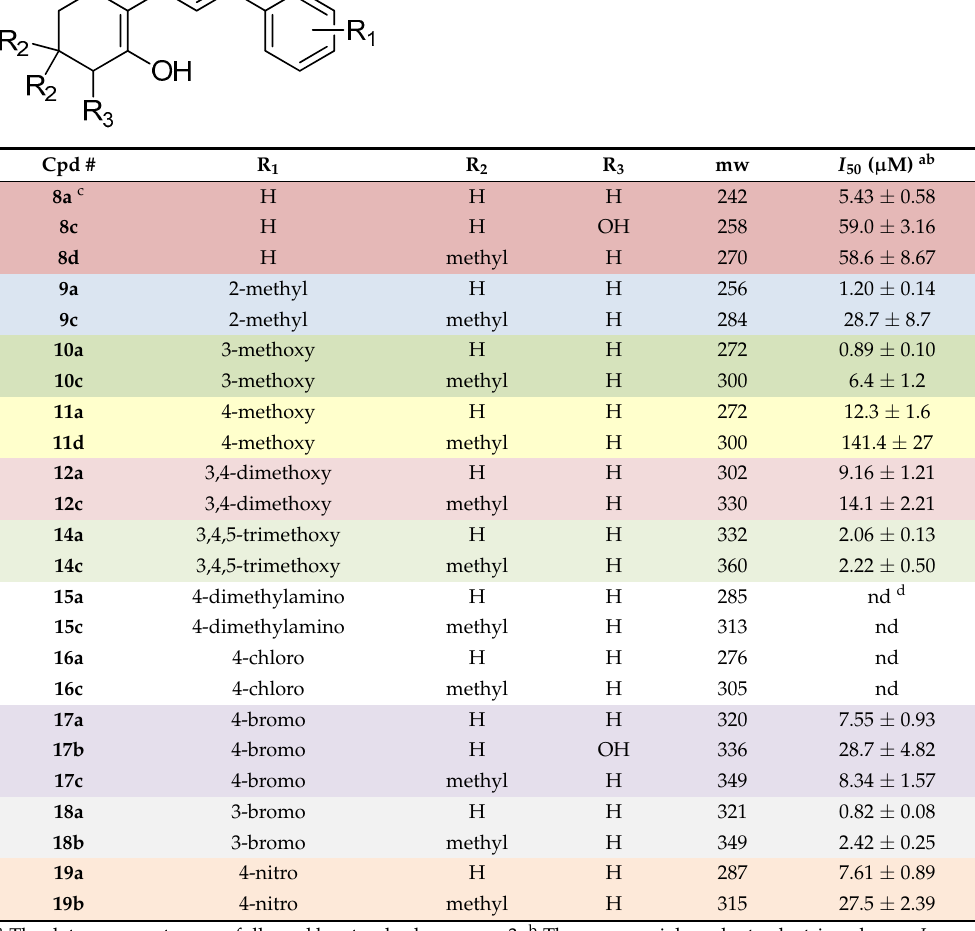
Table 3. Structures and activities of 24 cyclohexane-1,3-diones with phenylene side chains tested in this study.